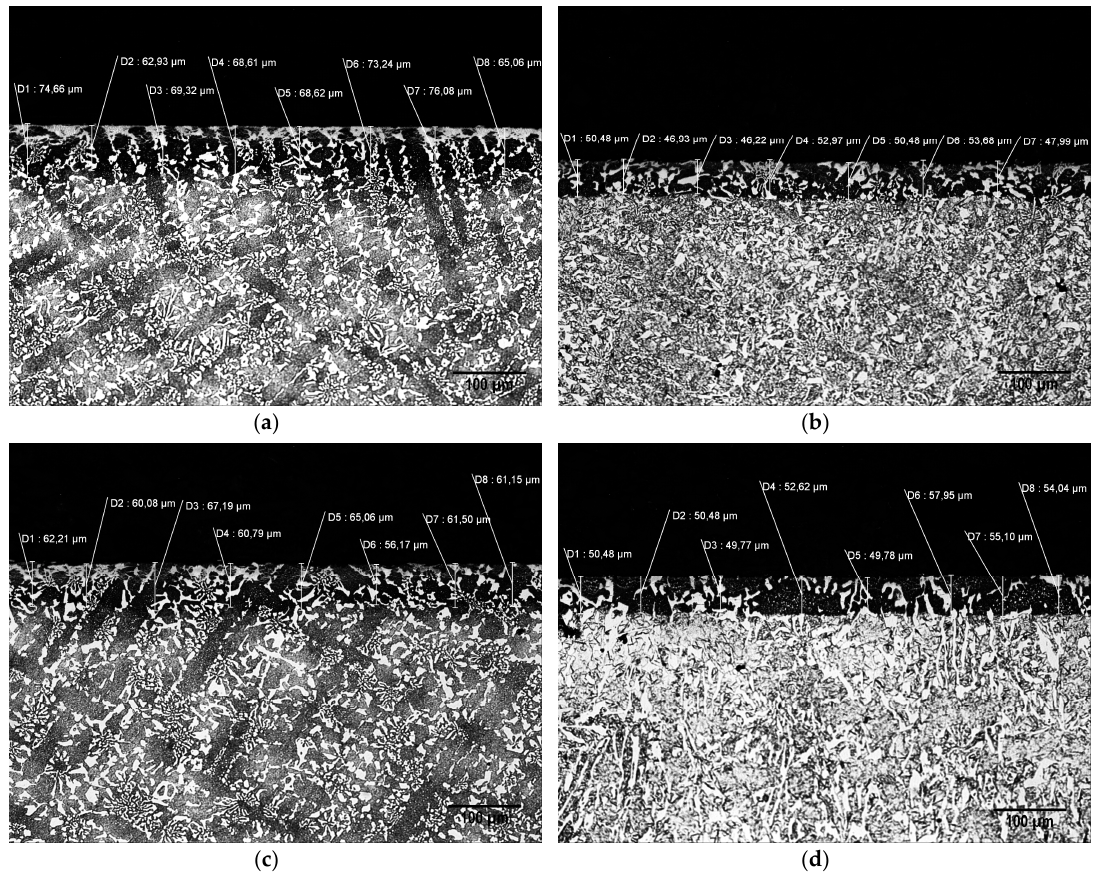
Figure 4. Representative image of the thickness of the nitrided layer. ( a ): Experiment 5; ( b ): Experiment 6; ( c ): Experiment 7; ( d ): Experiment 8.